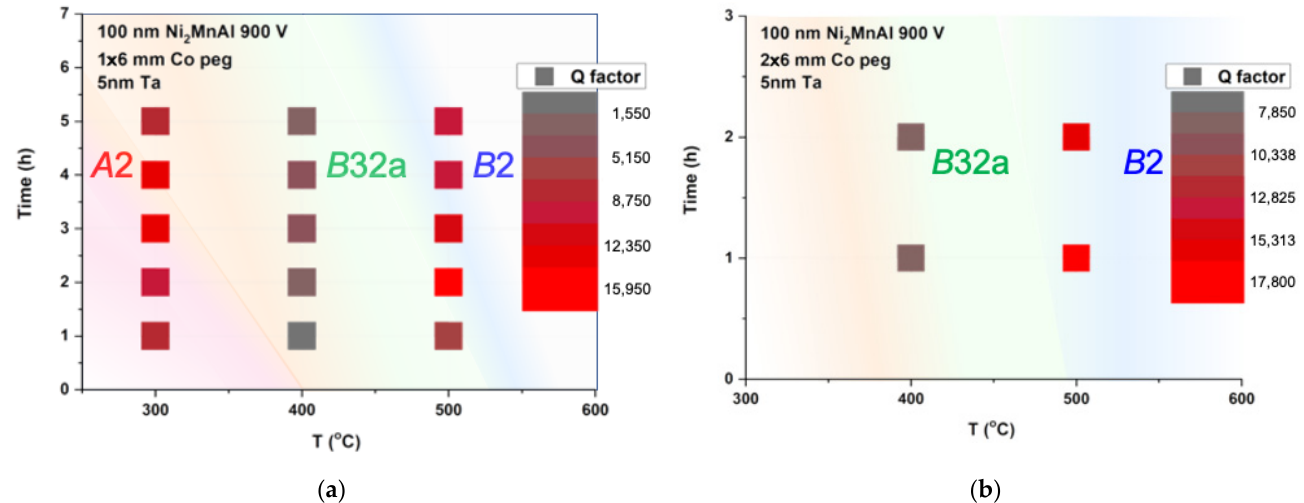
Figure 7. Crystallisation of the Ni 2 MnAl thin films doped with ( a ) one and ( b ) 6 mm Co pegs indicated by Q factors.